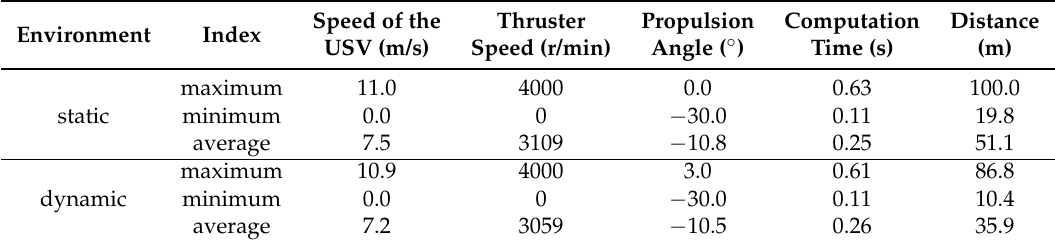
Figure 19. Evaluation results in the simulation environment. ( a ) Speed of the unmanned surface vehicle (USV); ( b ) Course of the USV; ( c ) Thruster speed; ( d ) Command propulsion angle; ( e ) Computation time; ( f ) Distance between the USV and collision area. Table 2. Results of evaluation index comprised of two tests in the simulation environment. USV: unmanned surface